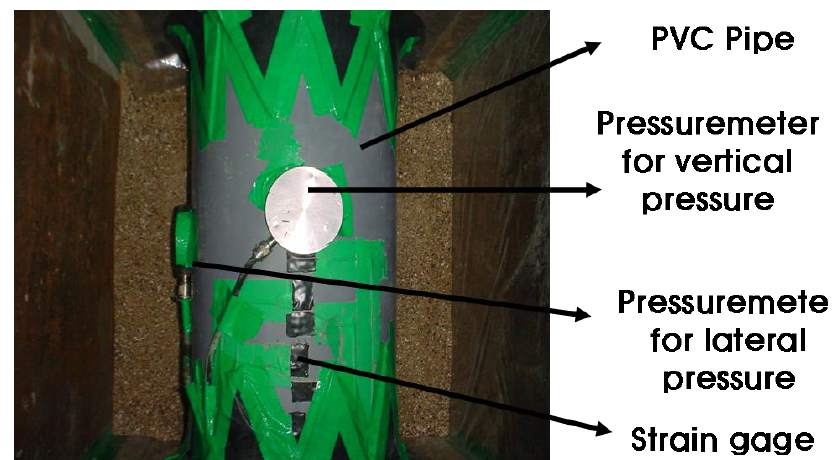
Figure 7. Pressuremeter.